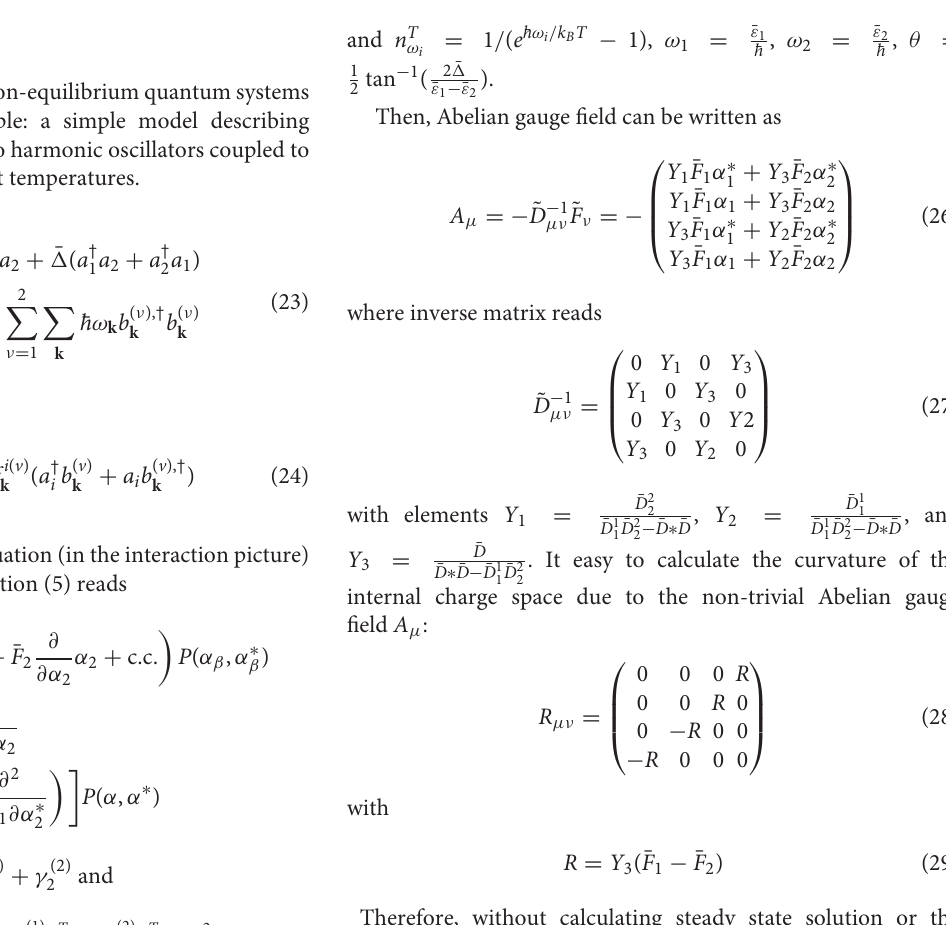
FIGURE 1 | Coherence C ( ρ ) varies as the function of the curvature R . Red, Blue, and Green lines represent F 2 1ε ε 1 ε 2 0.2 ev and (B) 1ε = − =